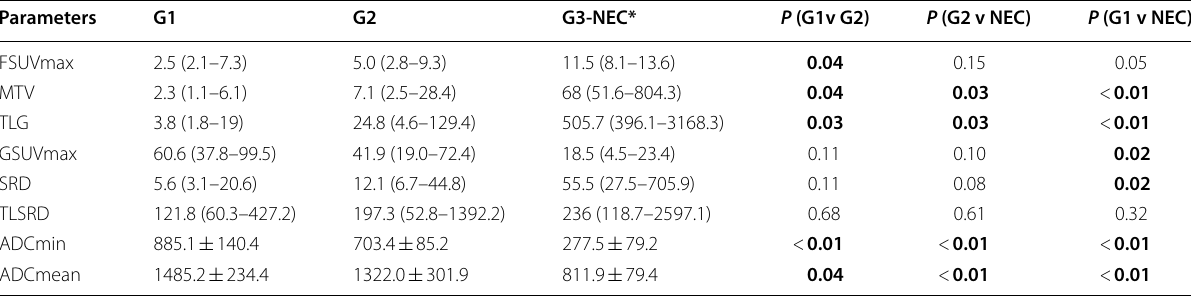
Values are presented as median with interquartile range (IQR) in parentheses. The statistically significant differences are highlighted in bold